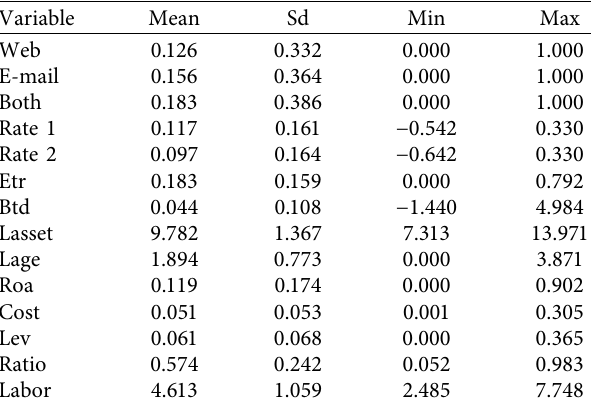
Table 2: Descriptive